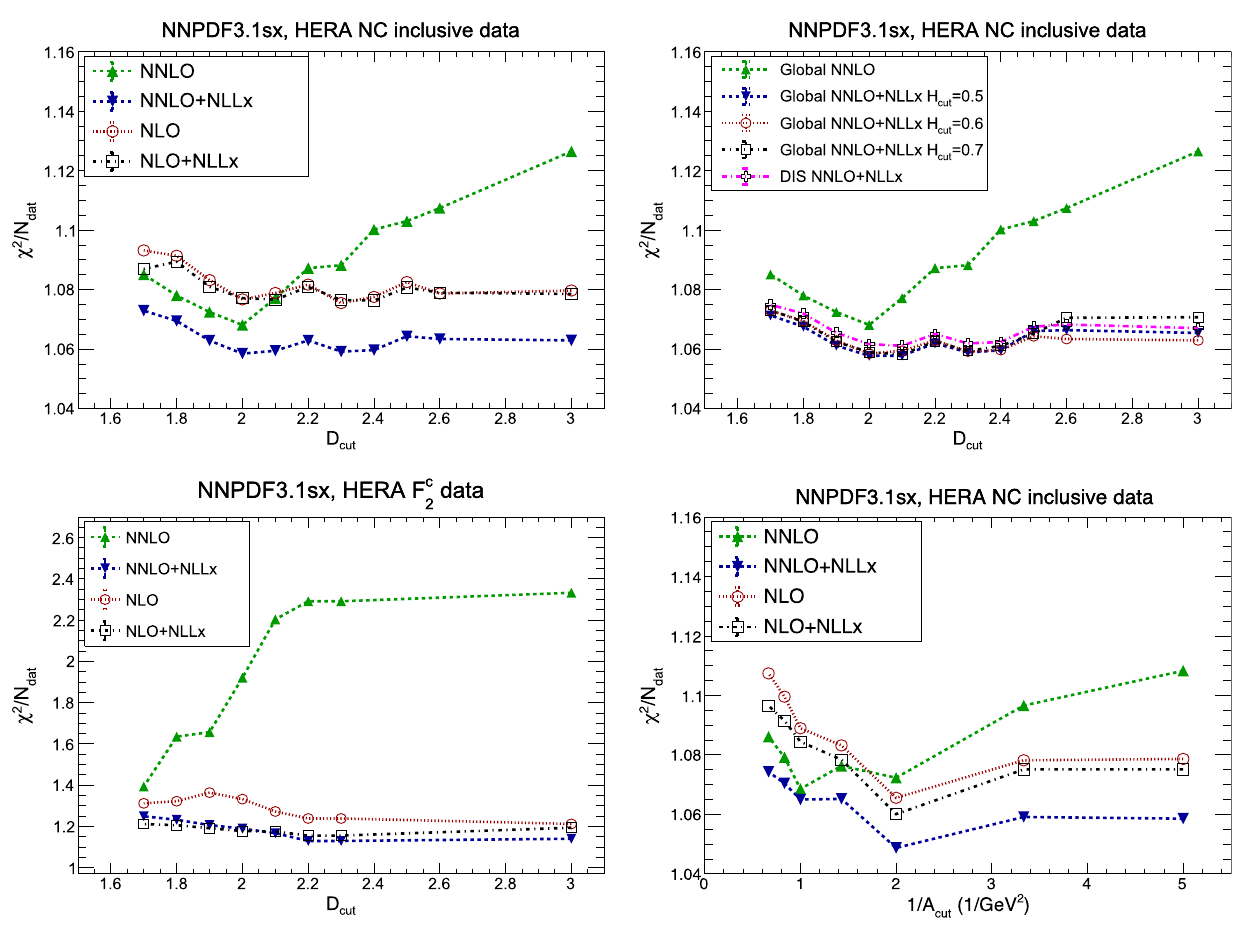
Fig. 24 Upper left: the values of χ 2 / N dat in the NNPDF3.1sx global fits for the HERA NC inclusive structure function data for different values of the cut D cut Eq. (5.2), comparing the results of the NLO, NLO+NLL x , NNLO, and NNLO+NLL x fits. Upper right: same com- parison, now between the global NNLO and NNLO+NLL x baseline